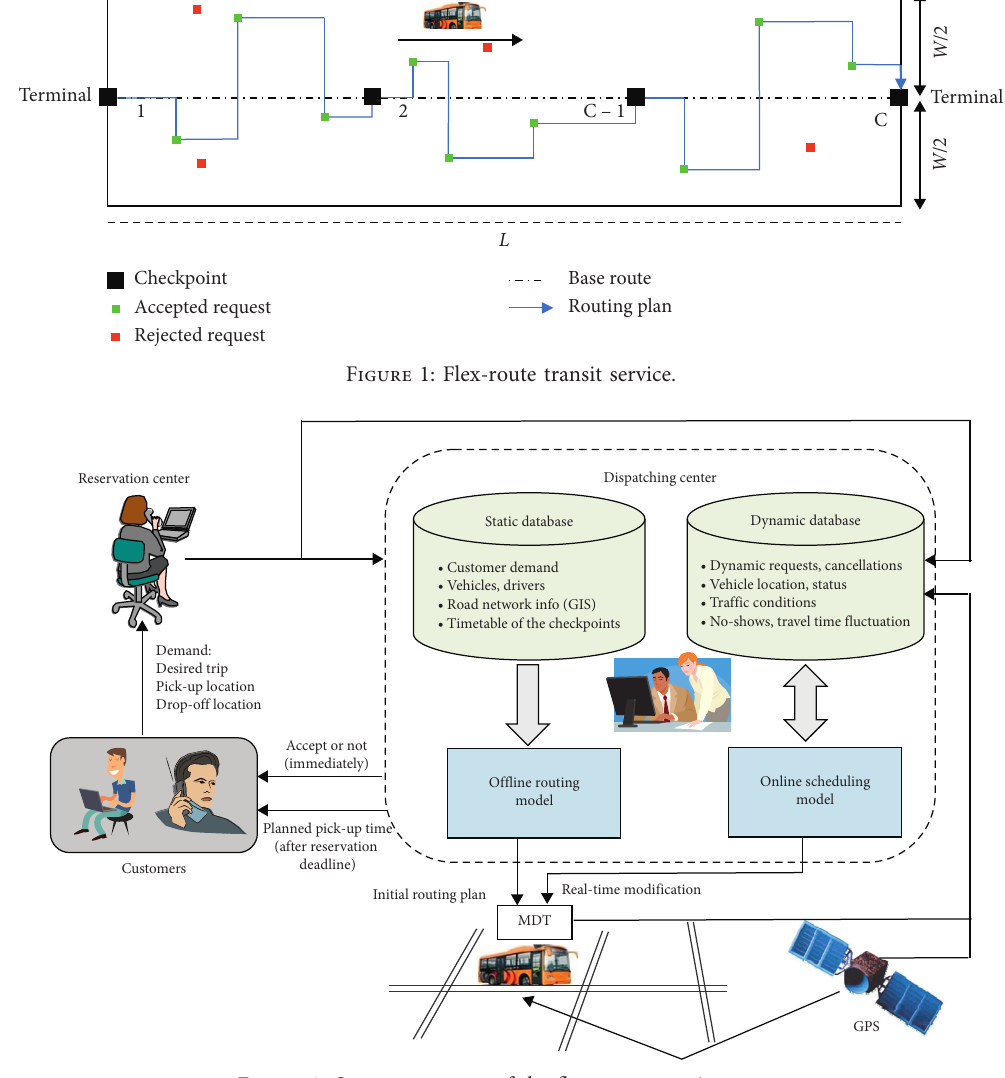
Figure 2: System structure of the flex-route transit